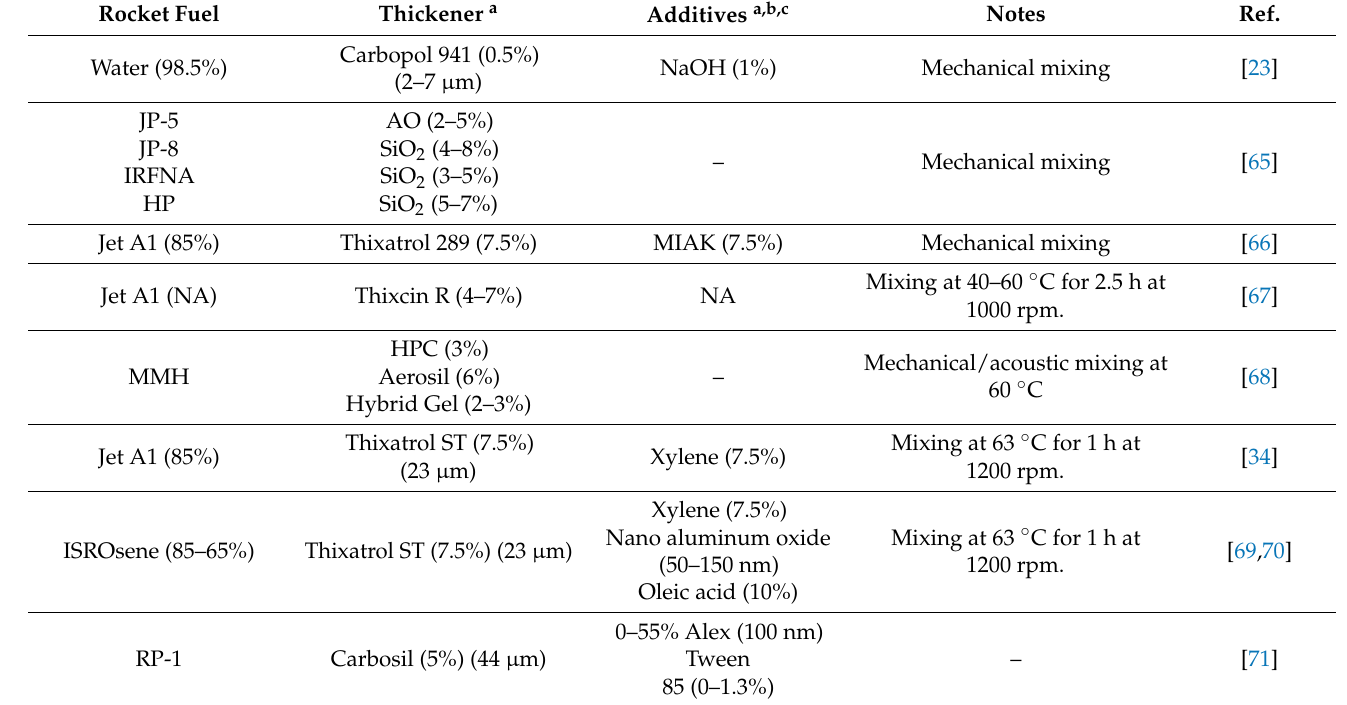
Table 1. Compositions of typical gel